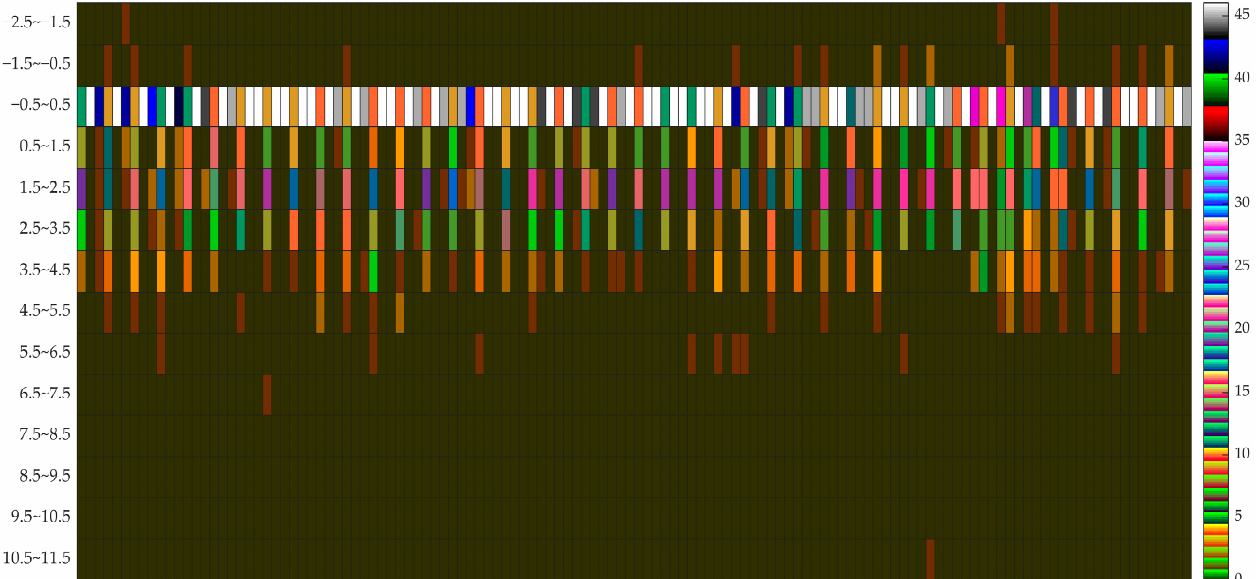
Figure 3. Stability calculation results (horizontal coordinates from left to right, a total of 126 cells, respectively, for the 1st to the 126th respectively, 42 markers in x-plane, y-plane, and z-plane stability results, the order is consistent with the serial number of Table 3).